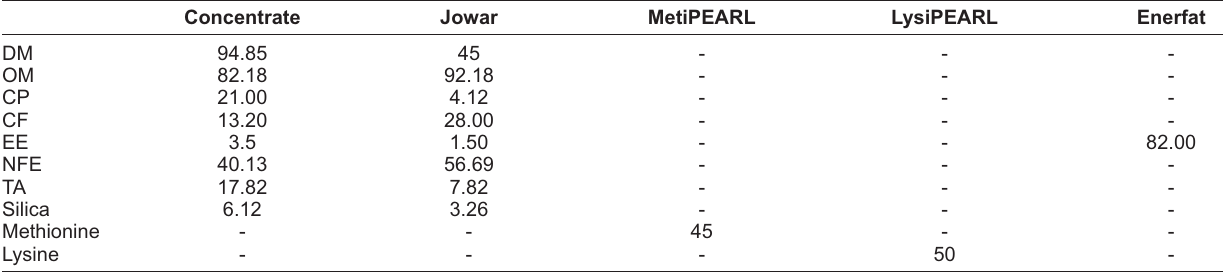
Table-1. Percent average composition of feed and fodder (on DM basis) fed to the experimental